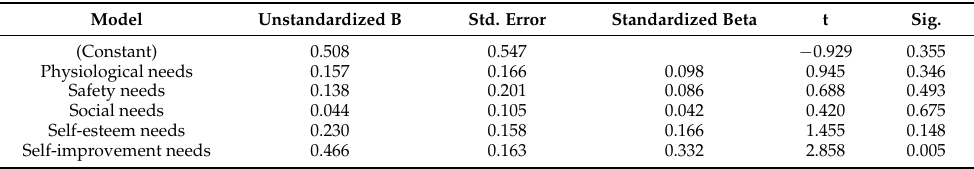
Table 4. Coefficient Behavioural